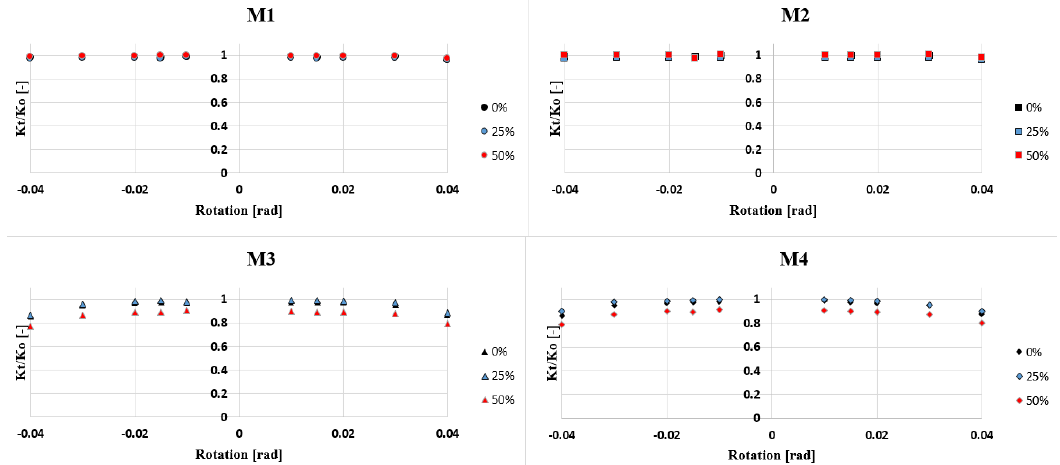
Figure 7. Normalized tangent stiffness vs. rotation for the configurations studied.